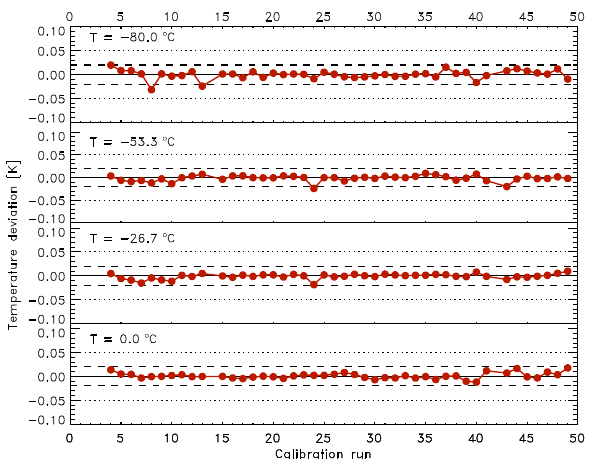
Figure 5. Deviation of the mean of five reference thermistors from the reference calibration temperature for each calibration